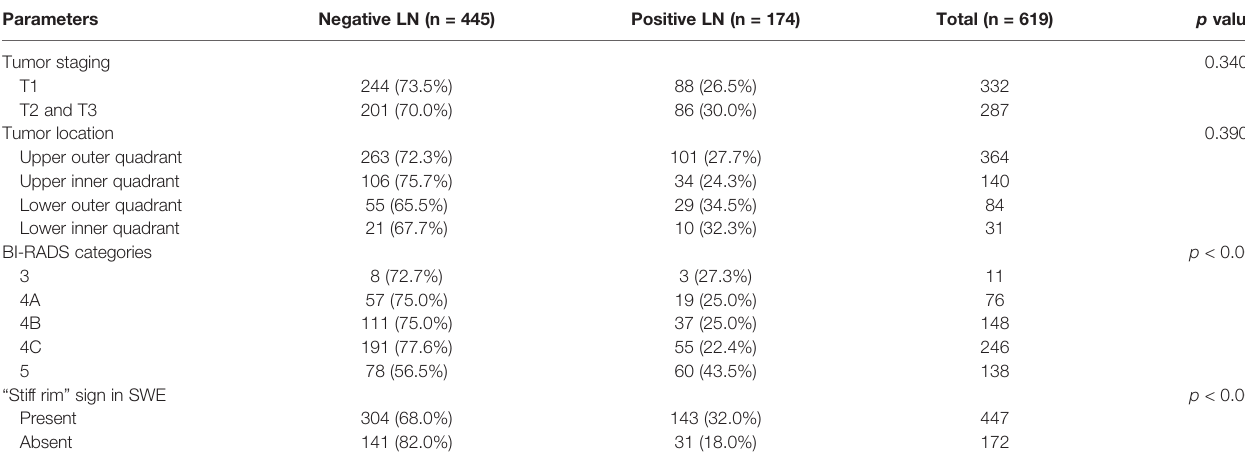
TABLE 2 | Clinical and ultrasound characteristics between negative and positive LN groups.